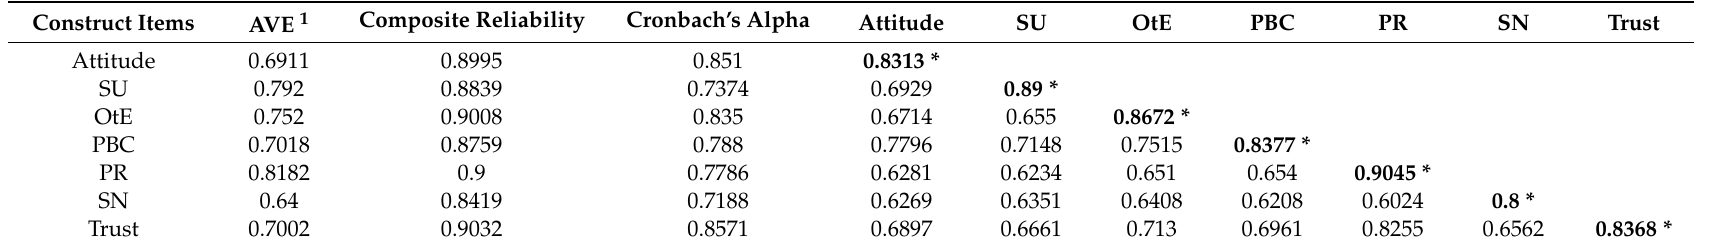
Table 2. Validity analysis of